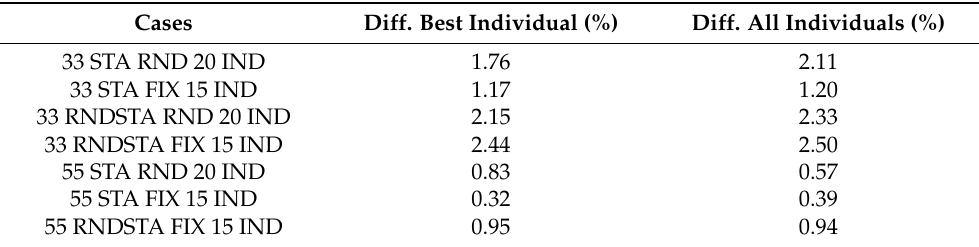
Table 2. Reduction of accuracy for the average fitness value of the best individual, and of all the individuals, using the new fitness function.